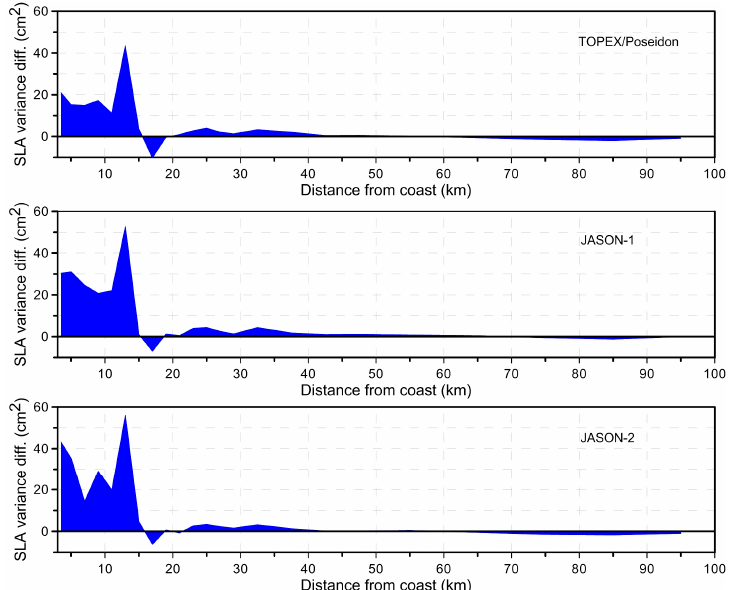
Figure 15. SLA variance differences (cm 2 ) function of distance from the coast between GOT4.10 and FES2012 tide models for TOPEX cycles 1 to 364, Jason-1 cycles 1 to 259 and Jason-2 cycles 1 to 280.